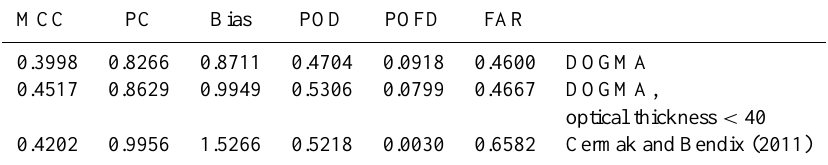
Table 6. Validation results for the DOGMA ground fog product.